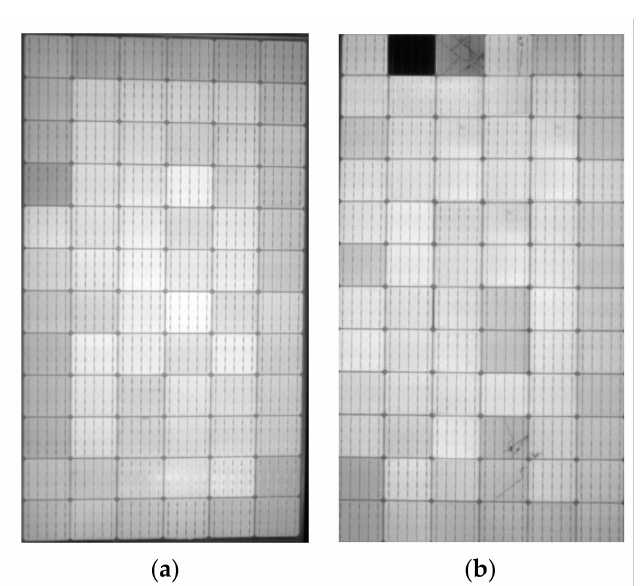
Figure 18. ( a ) The EL image profile of panel 1 in a good condition; ( b ) EL image profile of panel 2 which has a series crack condition.